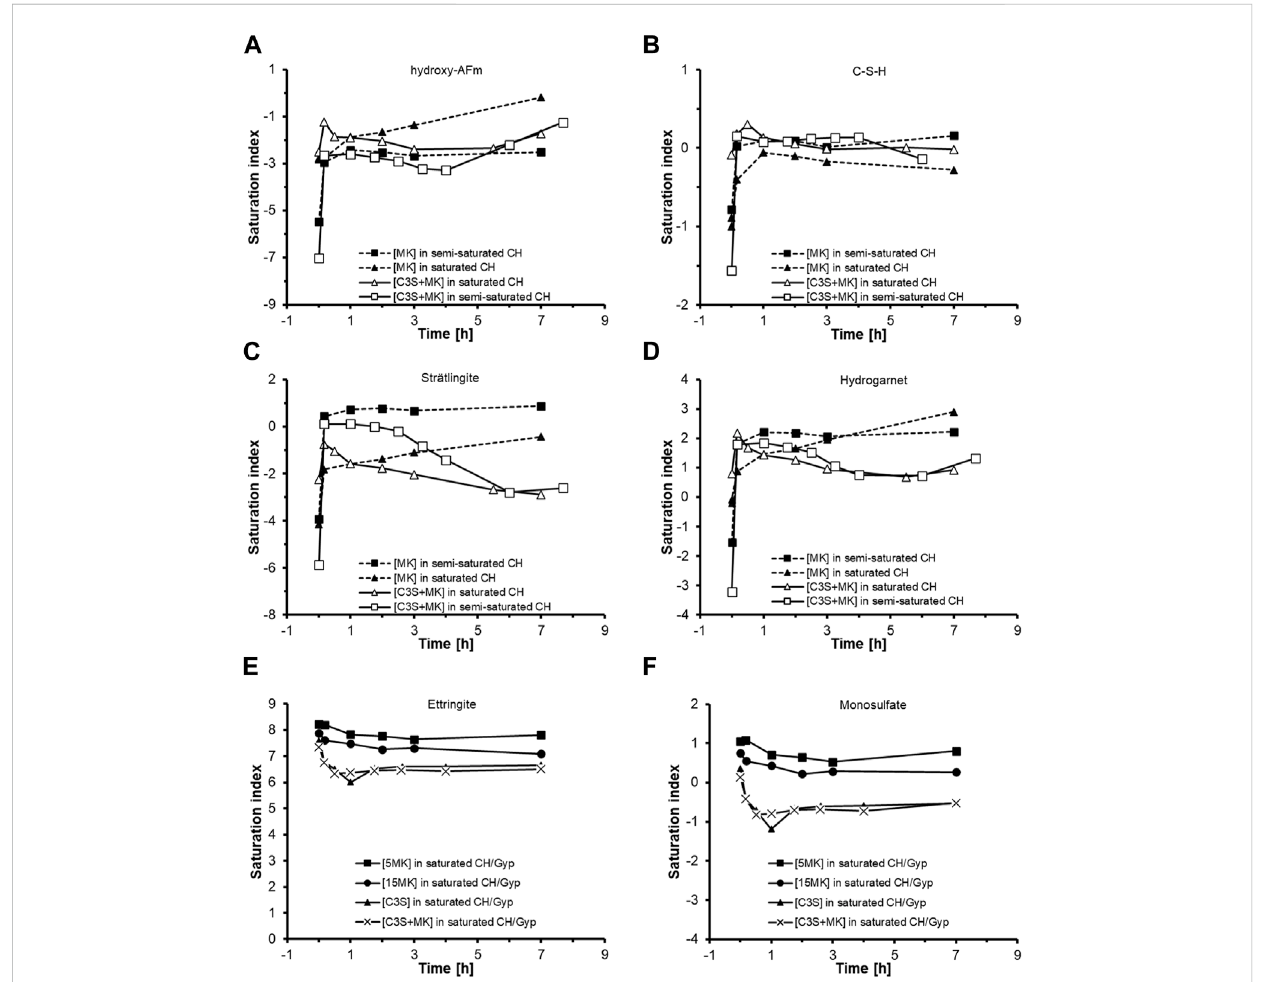
FIGURE 10 Saturation index of (A) hydroxy-AFm (Ca 4 Al 2 (OH) 14 (H 2 O) 12 ), (B) C-S-H ((CaO) 1.5 (SiO 2 ) (H 2 O) 2.5 ), (C) strätlingite (Ca 2 Al 2 SiO 7 (H 2 O) 8 ) and (D) hydrogarnet(Ca 3 Al 2 O 6 (SiO 2 ) 0.41 (H 2 O) 5.18 )usingtheaqueousphasecompositionofsuspensionsmadeofMKor[C 3 S+MK]startinginsemi-andsaturated Ca(OH) 2 -solutions at a MK-dosage of 10 g/L. The saturation index of (E) ettringite and (F) monosulfate (AFm) was calculated only for the suspensions hydrated in saturated Ca(OH) 2 -CaSO 4